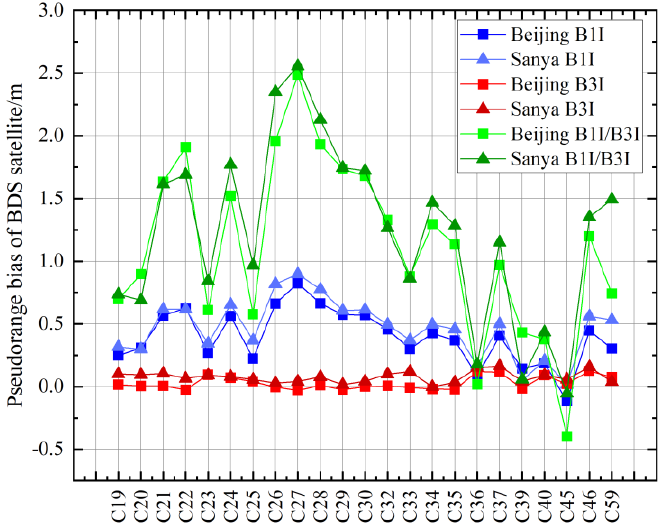
Figure 3. The pseudorange bias of the type B receivers to the Beidou satellite in the B1I, B3I and B1I/B3I signals.